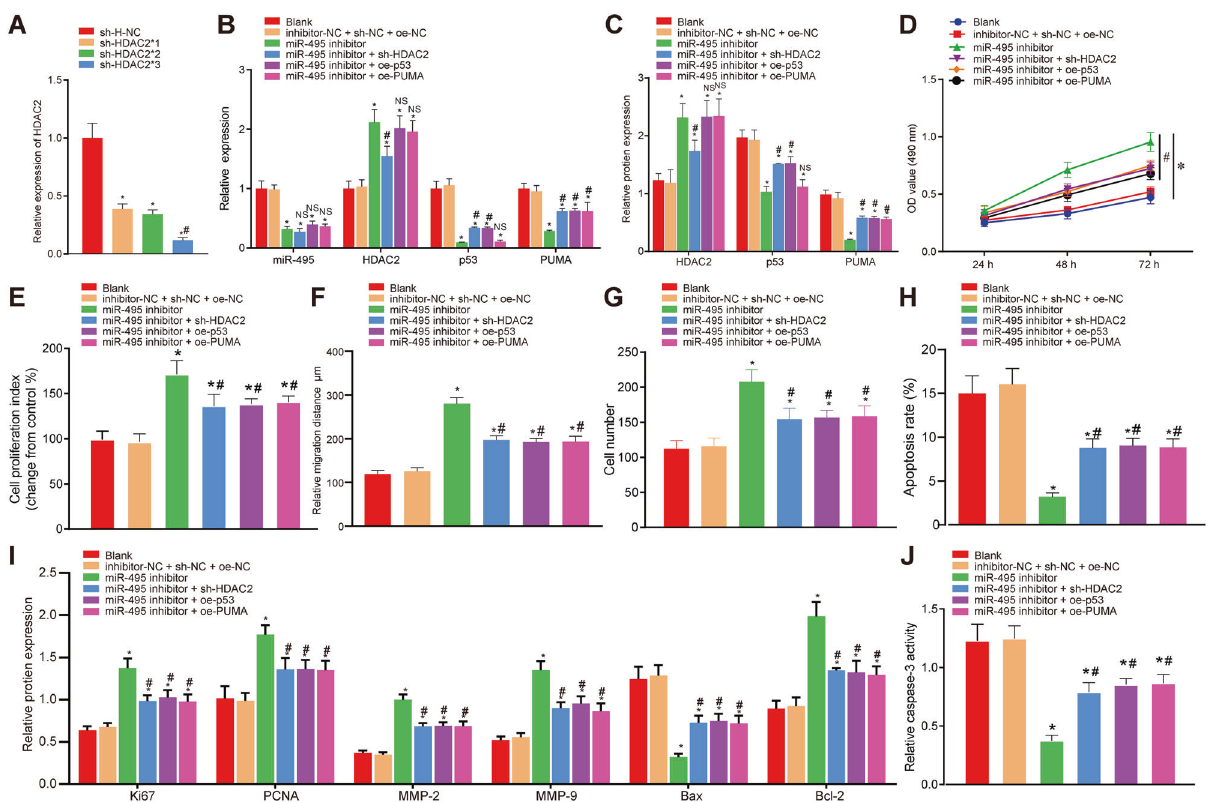
Fig. 6 Downregulated miR-495 prevents PE by upregulating HDAC2 via inhibition of p53/PUMA axis in HTR8/SVneo cells. A Knockdown ef fi ciency of HDAC2 analyzed by RT-qPCR. B miR-495, HDAC2, p53, and PUMA mRNA expression 48 h after transfection tested by RT-qPCR. C Western blot detection on protein expression of HDAC2, p53, and PUMA 48 h after transfection. D HTR8/SVneo cell viability evaluated by MTT assay. E HTR8/SVneo cell proliferation 48 h after transfection evaluated by BrdU assay. F Migrating ability of HTR8/SVneo cells 24 h after transfection examined using scratch assay. G HTR8/SVneo cell invasion 24 h after transfection assessed using transwell assay. H HTR8/SVneo cell apoptosis in each group 48 h after transfection analyzed by fl ow cytometry. I Protein expression of Ki67, PCNA, MMP-2, MMP-9, Bax, and Bcl-2 in HTR8/SVneo cells 48 h after transfection studied by western blot. J Caspase-3 activity in HTR8/SVneo cells 48 h after transfection. * p < 0.05 vs. blank or inhibitor NC + sh-NC + oe-NC; # p < 0.05 vs. miR-495 inhibitor. The quantitative data were presented as mean ± standard deviation. Difference between two groups was analyzed using paired t- test. Data among multiple groups were processed using one-way ANOVA followed with Tukey ’ s post hoc test. Cell experiments were repeated 3 times.